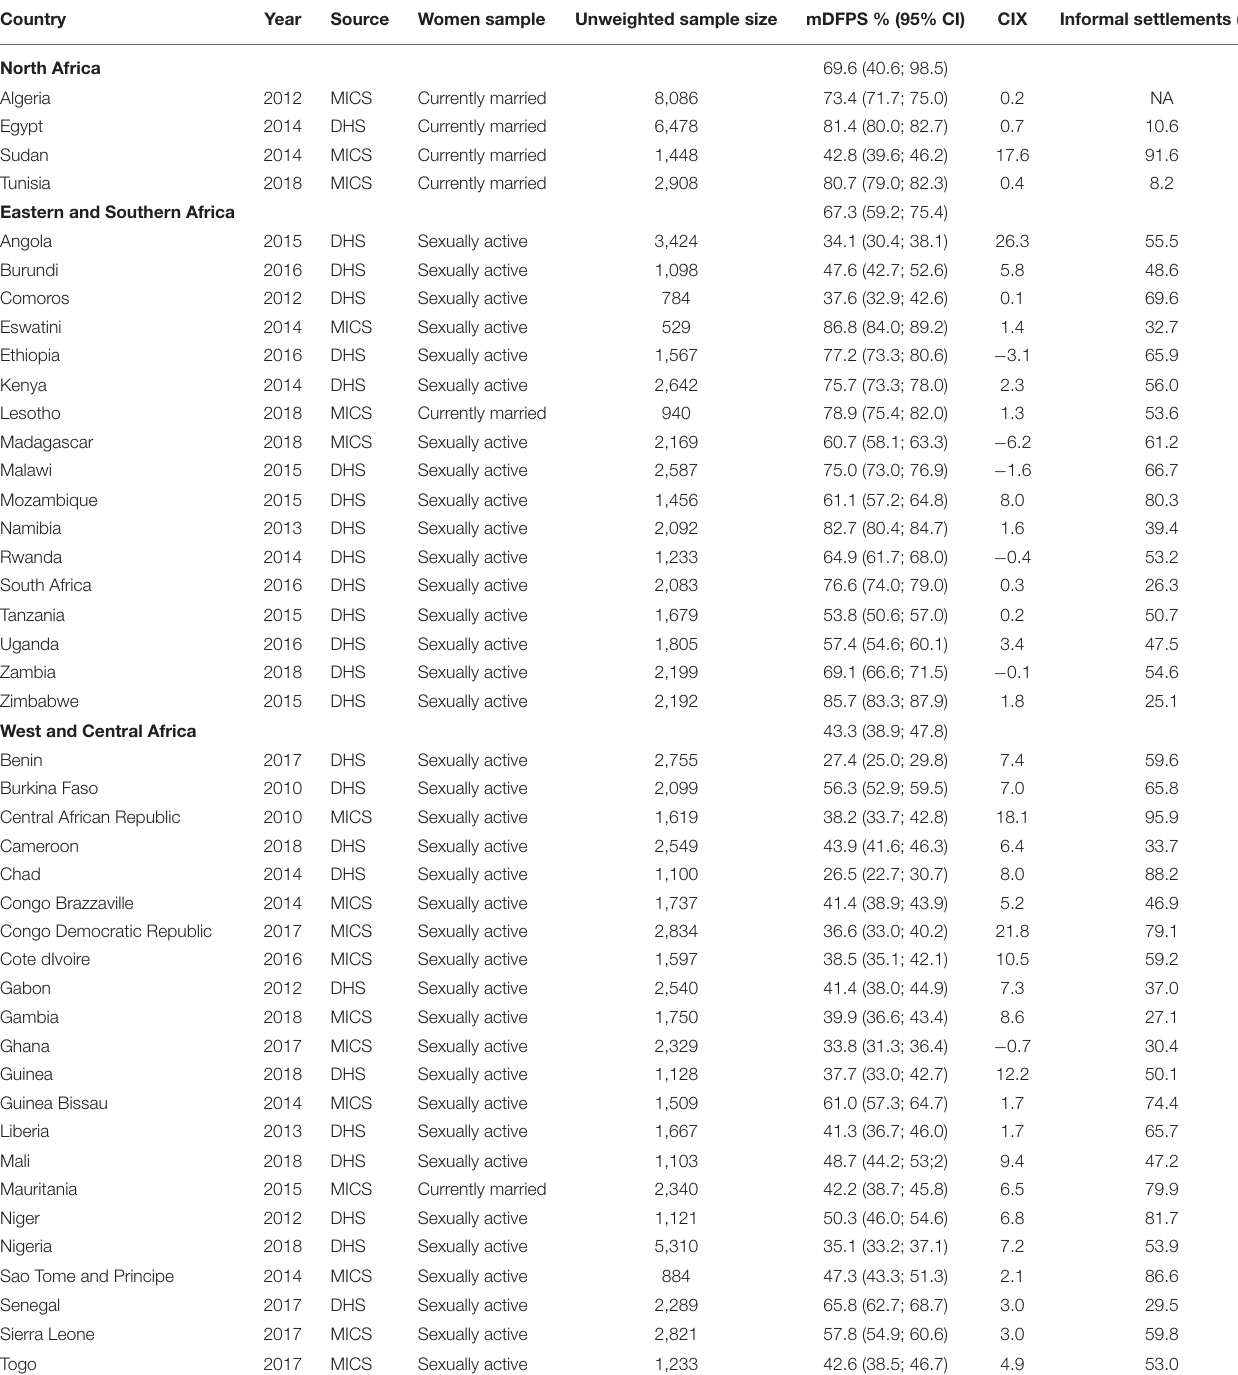
TABLE 1 | Countries included, sample characteristics, demand for family planning satisfied by modern methods (mDFPS), concentration index of inequality (CIX), and proportion of urban population living in informal settlements.